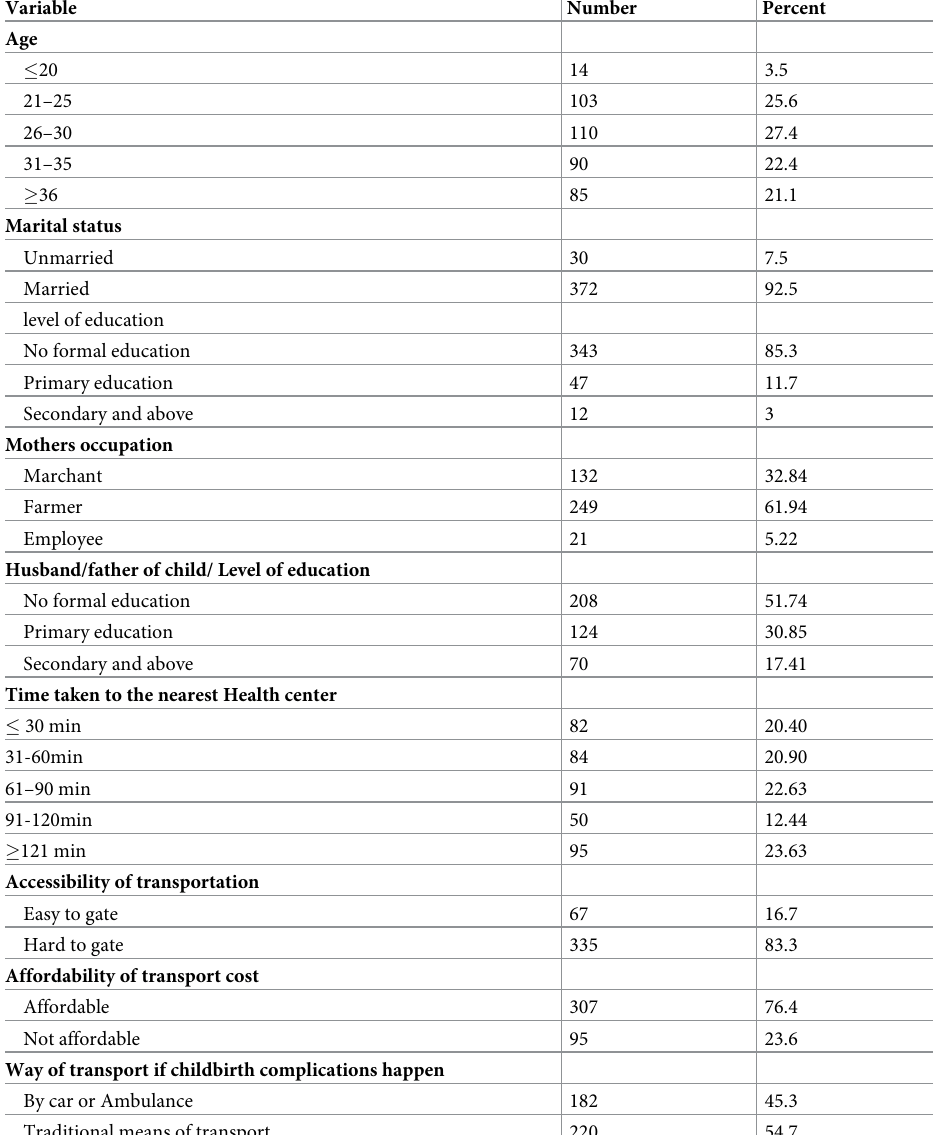
Table 1. Sociodemographic characteristics of the study participants in Dabat district northwest Ethiopia,